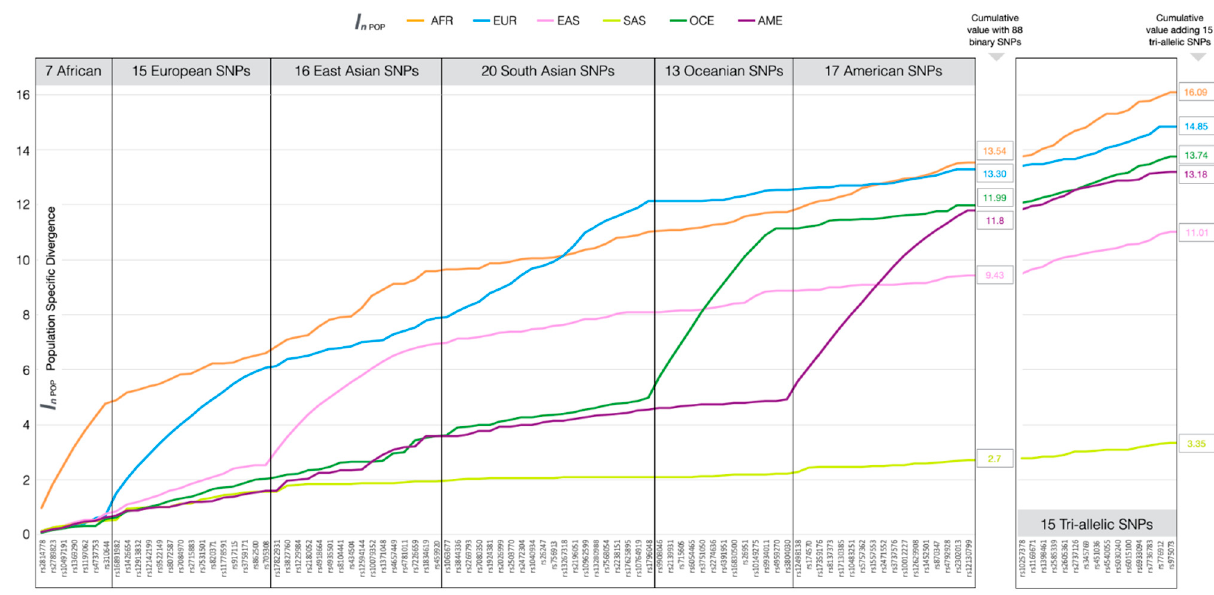
Figure 1. Accumulating population specific divergence values for each of the main population groups and the six sets of SNPs informative for their differentiation. The cumulative values are shown obtained from 88 binary SNPs (i.e., excluding 12 Eurasian-informative SNPs) and from the addition of the 15 tri-allelic SNPs in BT (VISAGE Basic Tool).